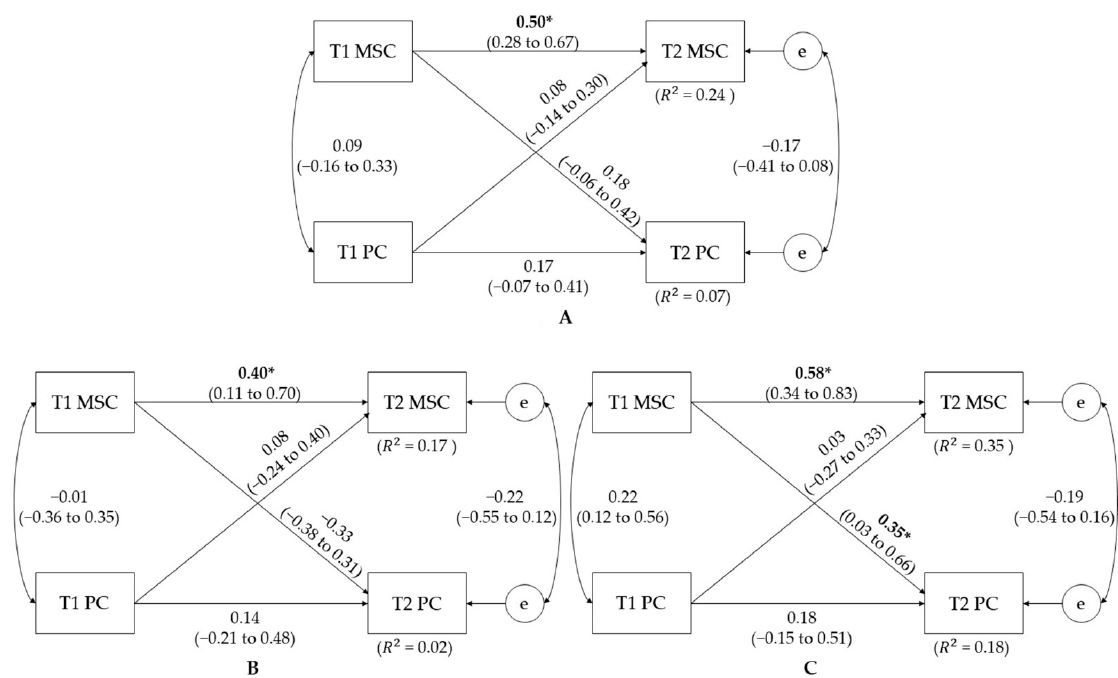
Figure 2. Cross-lagged model of the bidirectional relationships between MSC and PC before and after the 8-week study period for ( A ) total, ( B ) girls, and ( C ) boys. T1—baseline time; T2—follow-up time; PC—perceived competence. Path coefficients are standardized with 95% confidence intervals. * denotes a statistically significant path coefficient with p < 0.05.